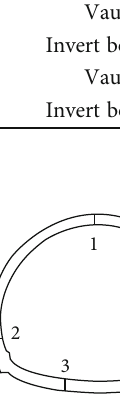
Figure 9: Layout of monitoring points for vault, arch waist ,and inverted arch: point 1: settlement monitoring point of vault, point